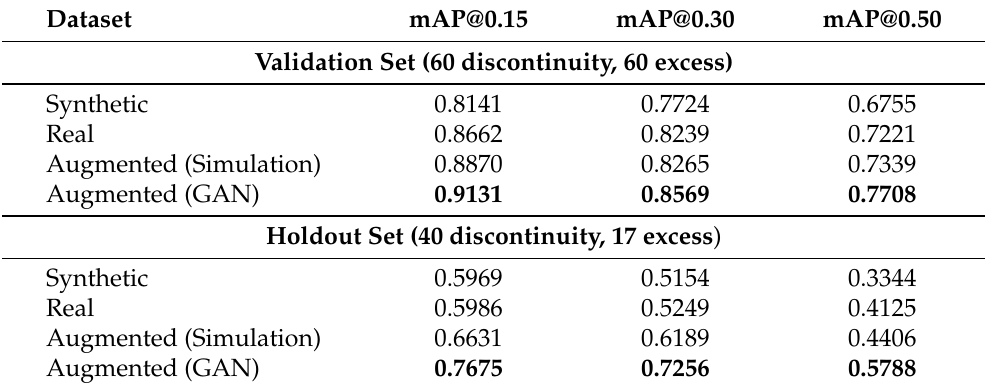
Table 1. Evaluation metrics for the models trained with synthetic set (536 images), the scarce real set (58 images) and the augmented sets (594 images for both). Models were first validated on a set of 58 real images, then on a holdout set of 19 real images. The number of instances of each defect is listed in the table. The mean Average Precision (mAP) is computed for different Intersection over Union (IoU) thresholds, namely 0.15, 0.30 and 0.50. Best results are highlighted in bold. Dataset mAP@0.15 mAP@0.30